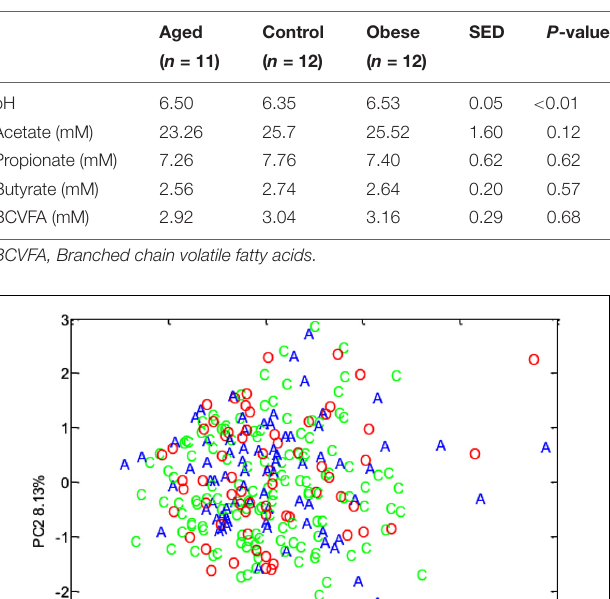
FIGURE 2 | Stacked histogram illustrating the relative abundance of the dominant bacterial genera (present at > 0.05%) across host phenotypic groups [Aged ( n = 11), Control ( n = 12), and Obese ( n = 12)].